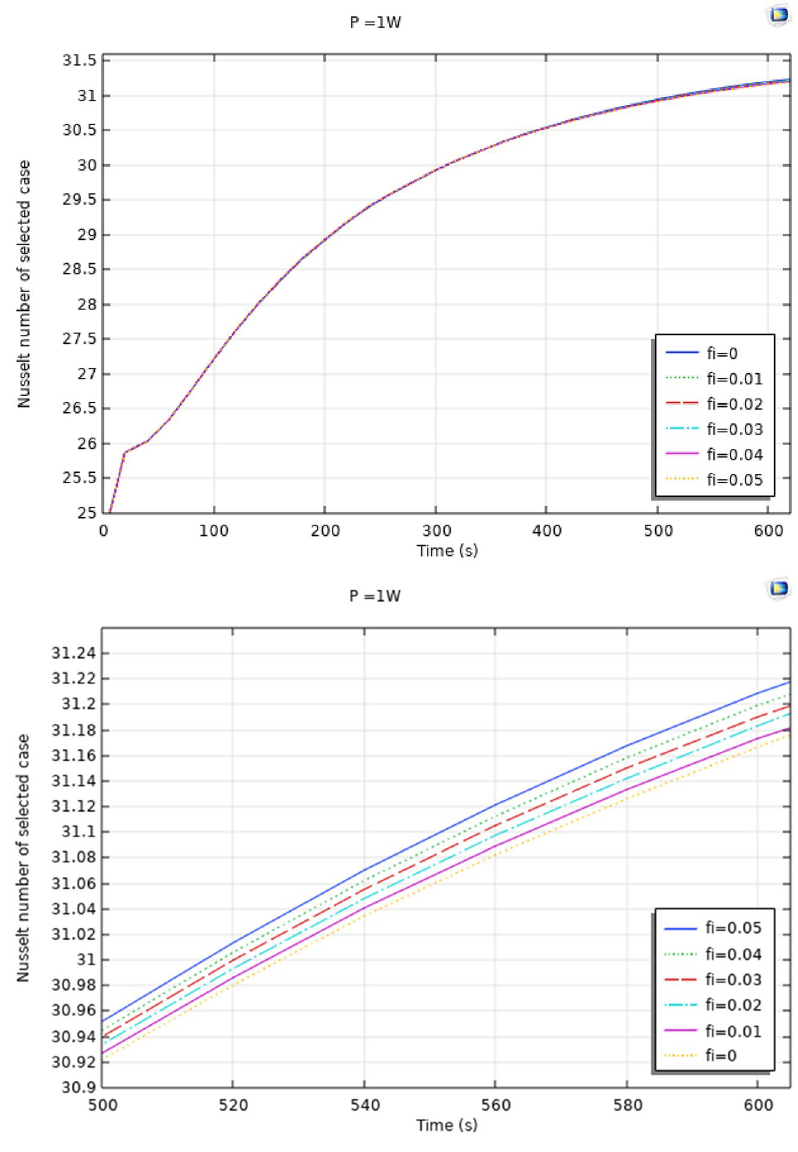
Figure 16. Effect of different nanoparticles concentration on Nusselt number of the optimized